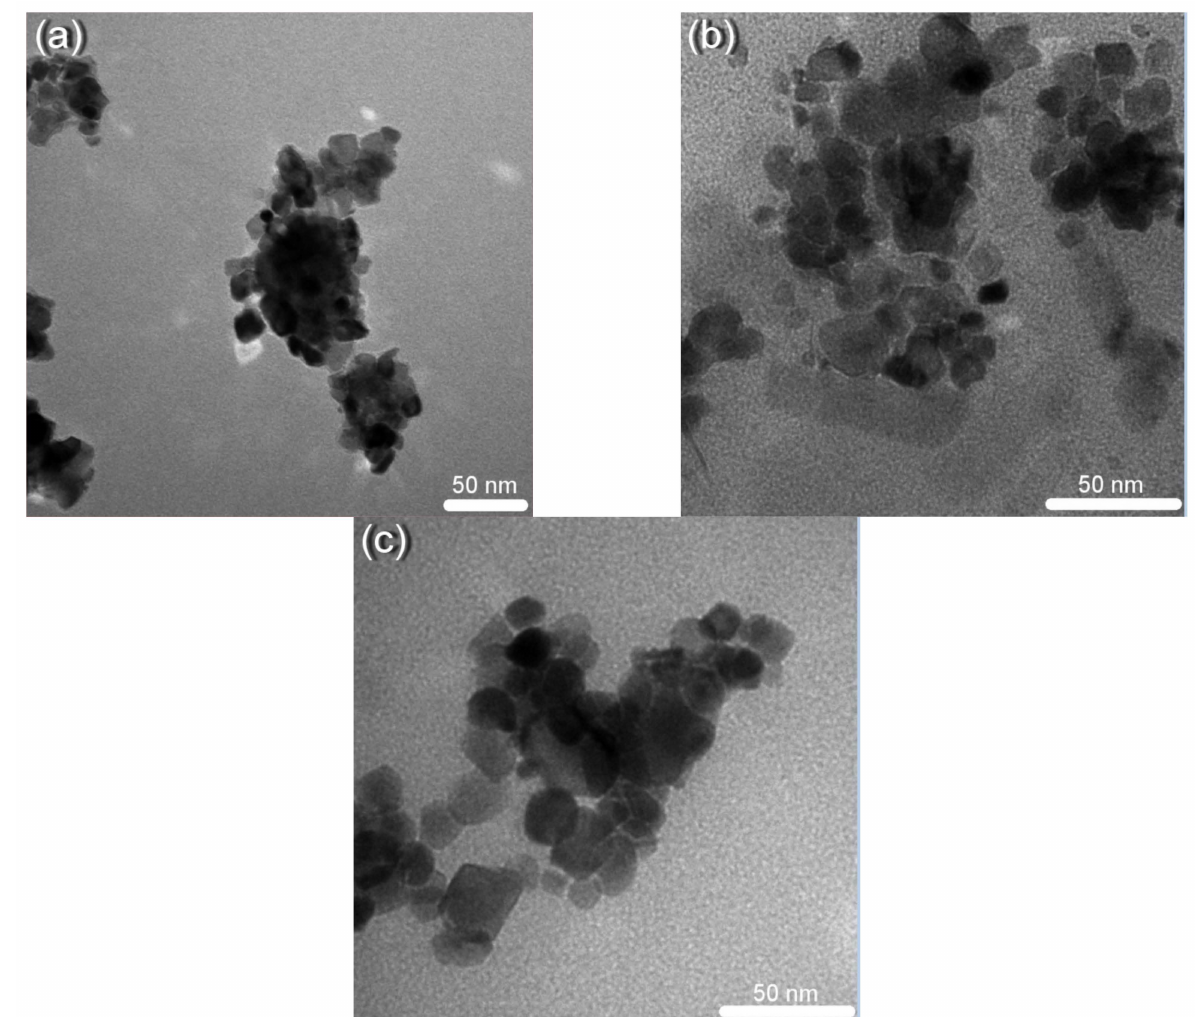
Figure 2. TEM images of cerium oxide nanoparticles: ( a ) CeO-1, ( b ) CeO-2, and ( c )